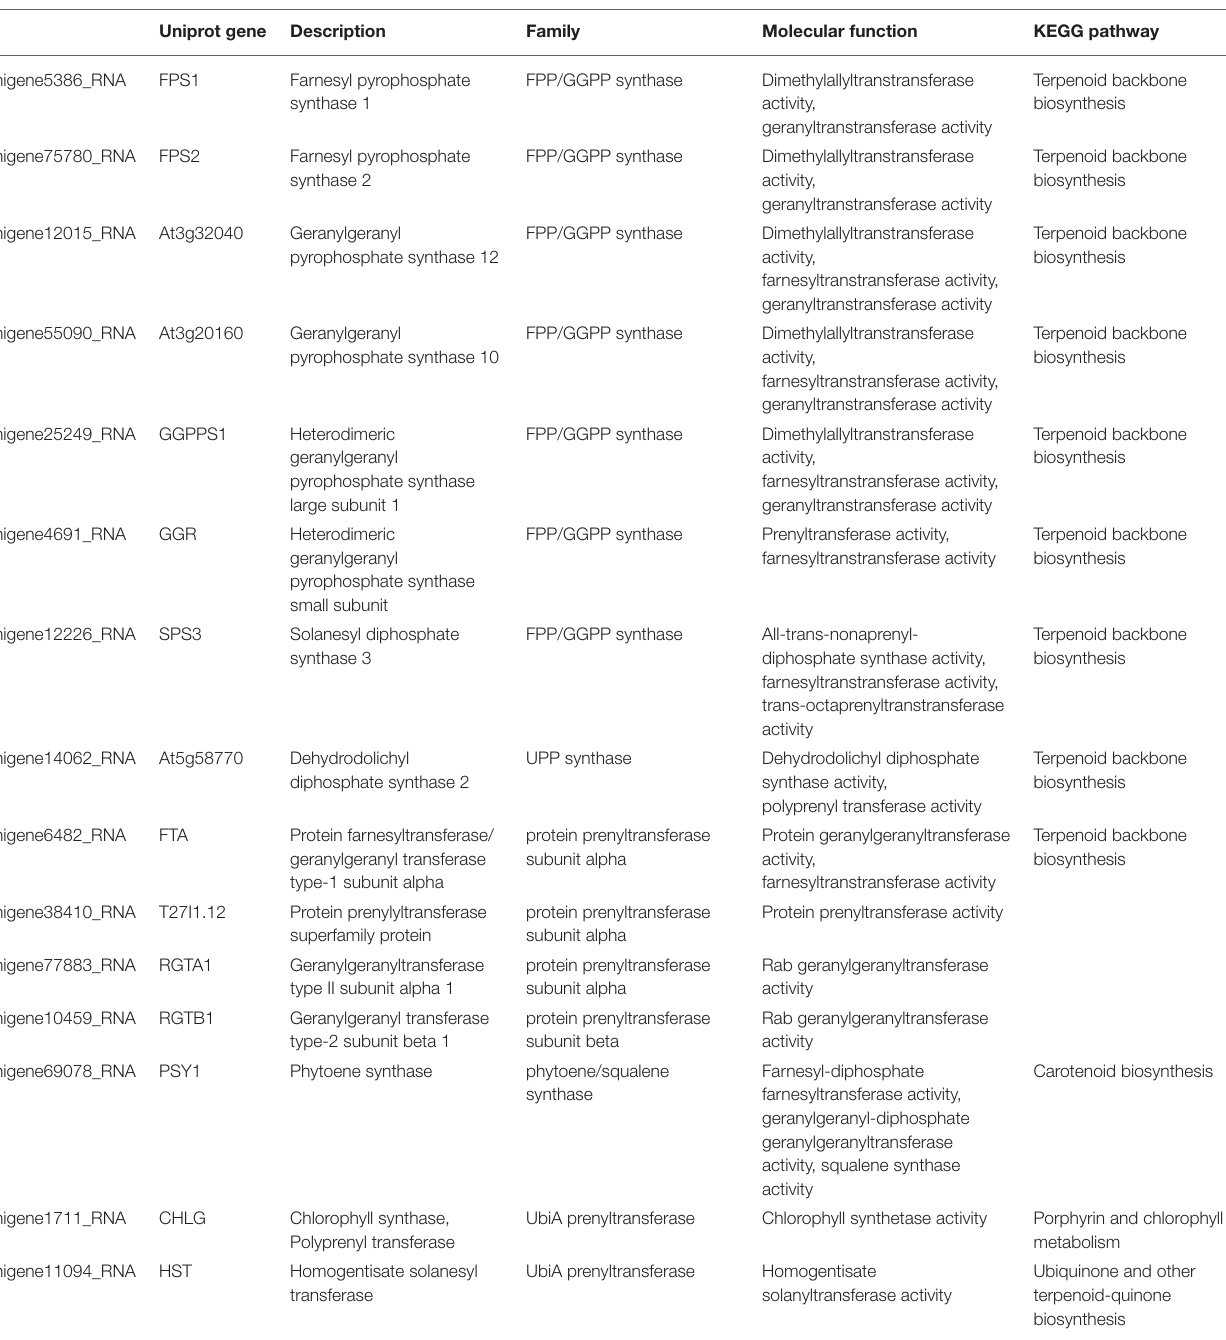
TABLE 3 | The analysis of prenyltransferase in R. glutinosa